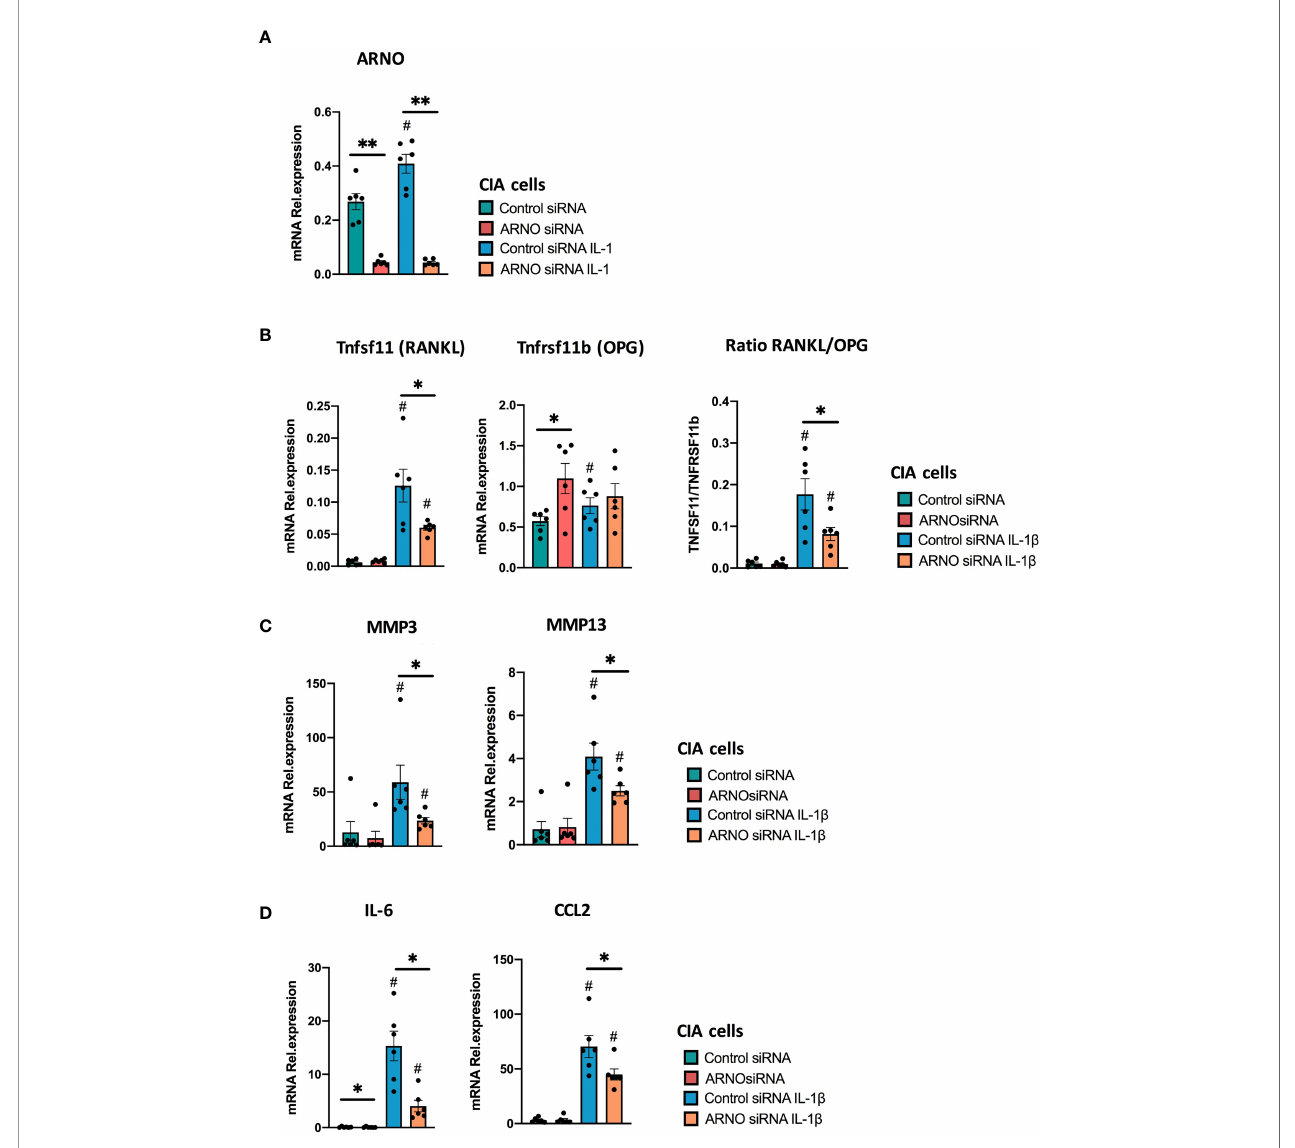
FIGURE 7 | ARNO knock-down decreases IL-1 b -dependent responses of CIA SFs. SFs were expanded from mice undergoing Collagen-Induced Arthritis, and RNA was isolated from unstimulated and IL-1 b -stimulated cells upon ARNO knock-down by siRNA or Allstar treatment. ARNO (A) TNFRSF11b and TNFSF11 (B) , MMP3, MMP13 (C) and IL-6, CCL2 (D) relative mRNA expression was evaluated by RT-qPCR using the DD C t method and actin as housekeeping gene. Each dot represents one independent experiment (analysed in triplicate), error bars represent SEM, *p < 0.05, **p < 0.01 versus respective siRNA control, # p < 0.05 versus unstimulated control, statistical signi fi cance was evaluated by the Mann-Whitney